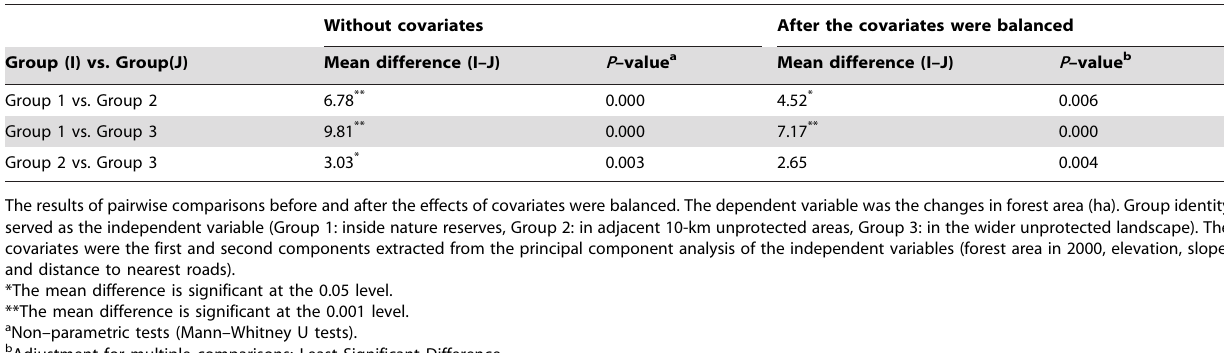
Table 3. Pairwise comparisons.